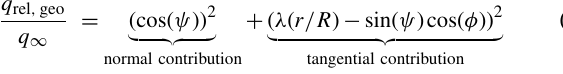
Figure 13. Normalized relative dynamic pressure at radial position r = 45% R for the yaw cases. The solid line shows the pressure tap estimation. The dashed line shows the geometrical